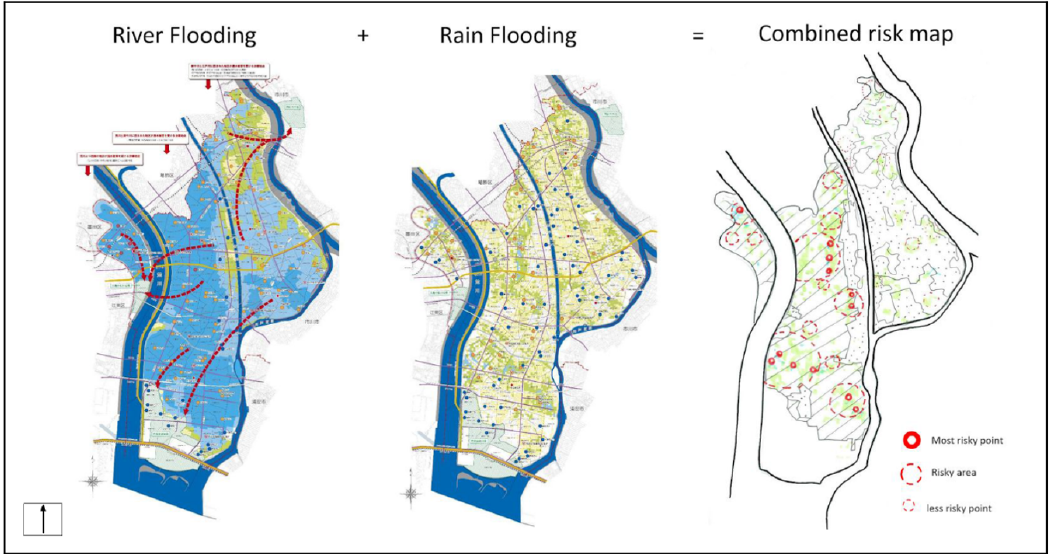
Figure 6. Risk zones (water ponding areas at the meso (ward) scale are identified using the: ( left ) drainage map of the two rivers flanking the Edogawa ward; ( middle ) drainage system of the Edogawa ward (data and map source: Ministry of Land, Infrastructure, Transport and Tourism (MLIT) Japan) [19,20]. Note that the left map indicates flooding from high river water levels, which can be caused by either high upstream (river) flows, or coastal storm surge (maps not to